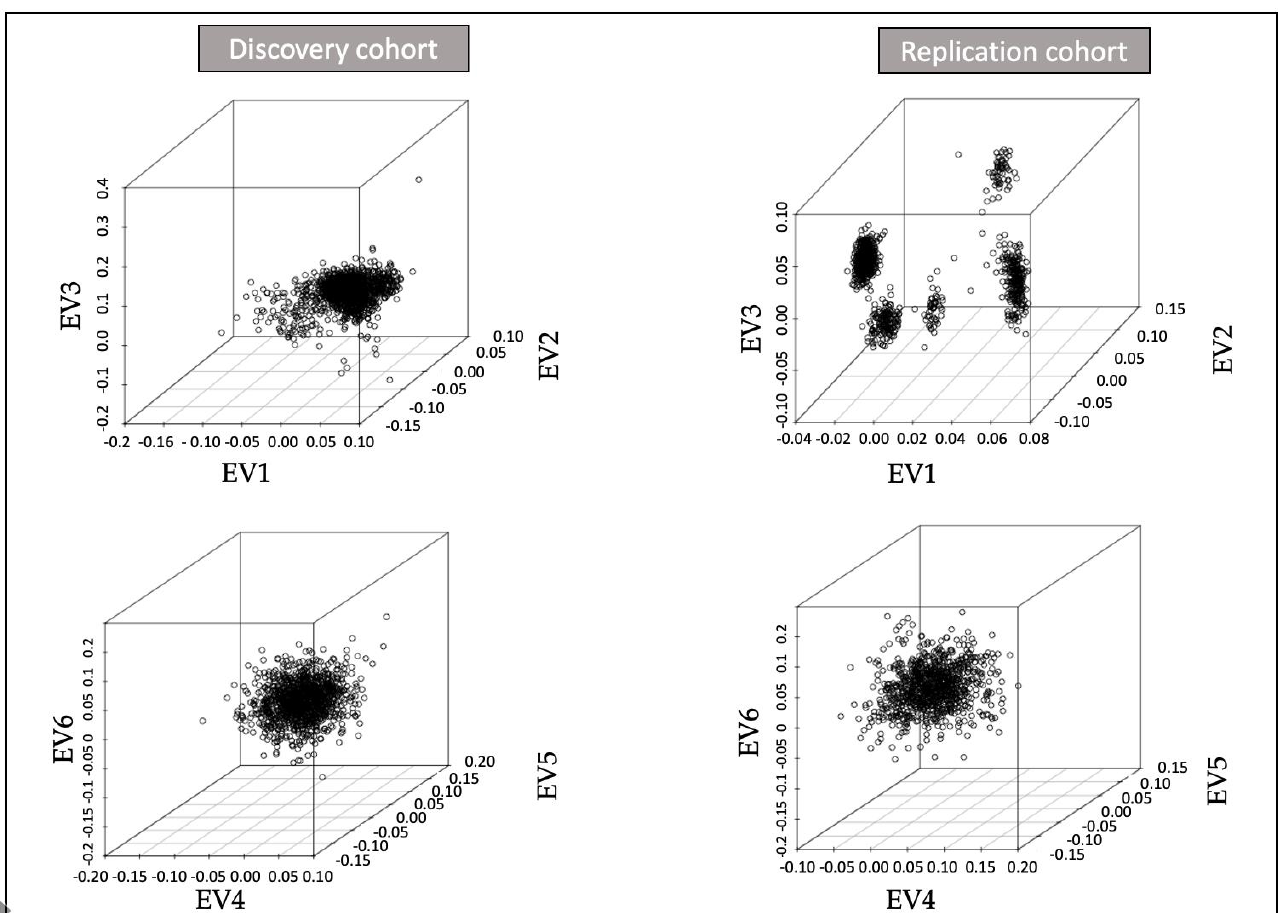
Figure 1. Principal component analysis (PCA) representation for discovery and replication cohorts. EV: eigenvector.